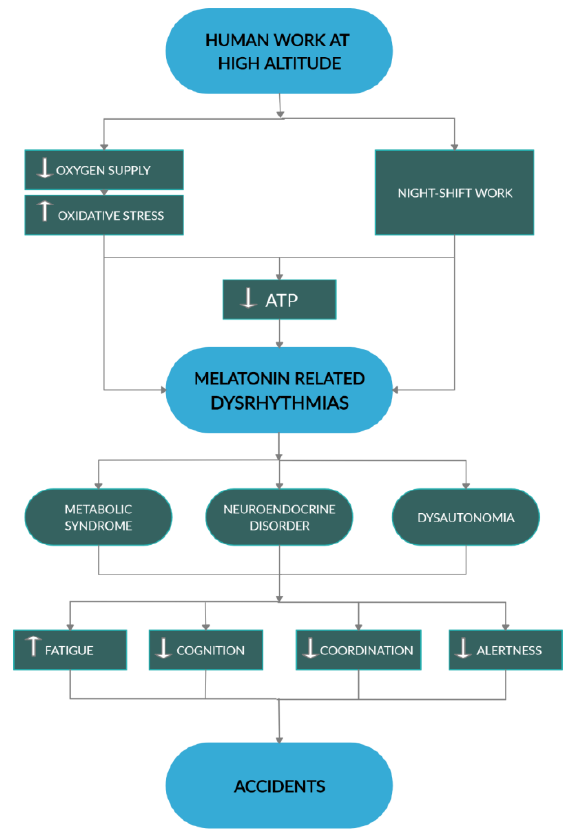
Figure 5. This diagram summarizes dysrhythmia centered mechanisms by which human work at HA may promote accidents. White arrows, respectively indicate increase and decrease. Black arrowheads indicate direction of processes.